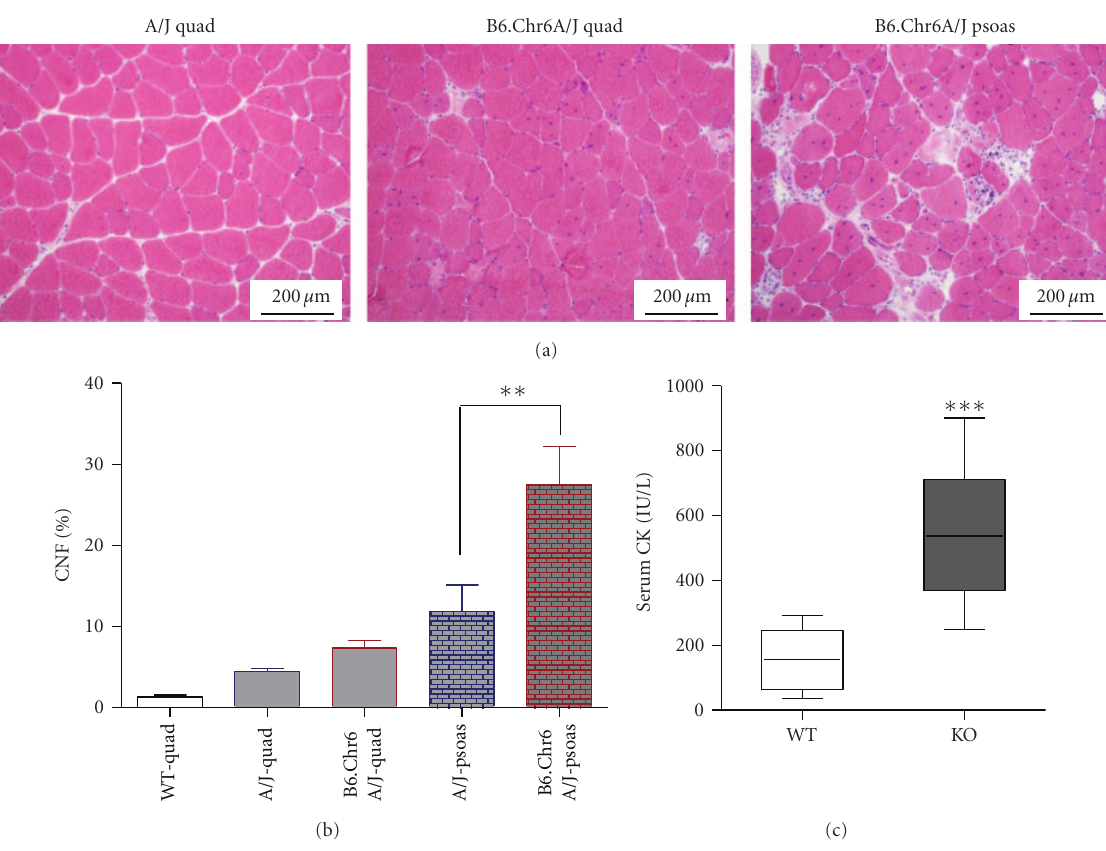
Figure 2: Characterization of C57BL/6J-Chr6 A / J /NaJ mice. (a) H&E-stained quadriceps (or iliopsoas) muscle sections of A/J, B6.Chr6A/J mice. Scale bar: 200 μ m. (b) Central nucleated muscle fiber percentage (CNF) from the quadriceps or iliopsoas muscles of WT, A/J, and B6.Chr6A/J mice at 16 weeks of age. (c) Serum creatine kinase (CK) levels from WT ( N = 6) and B6.Chr6A/J (KO) ( N = 10) mice at 16 weeks